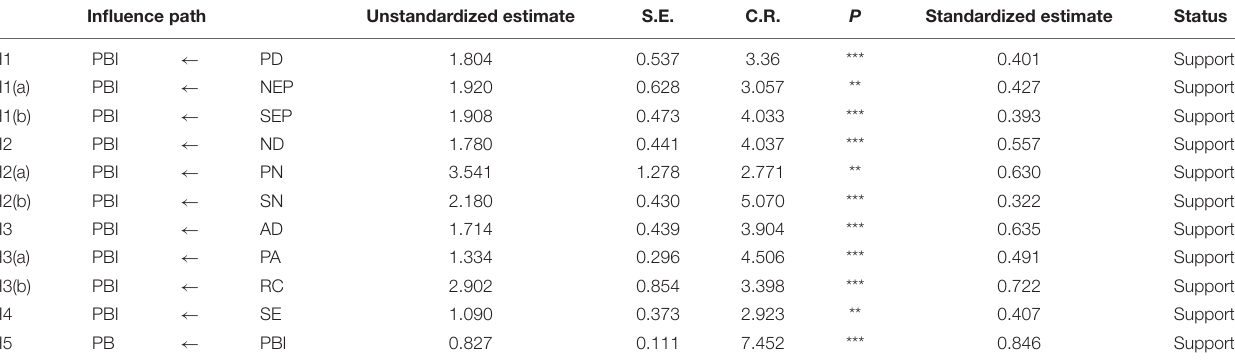
TABLE 7 | Results of hypothesis testing for the structural model. Influence path